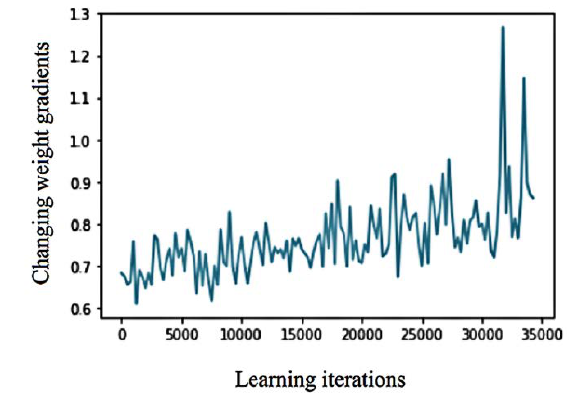
Fig. 7. Graph of changes in the gradients of weights of the third layer of an artificial neural network .